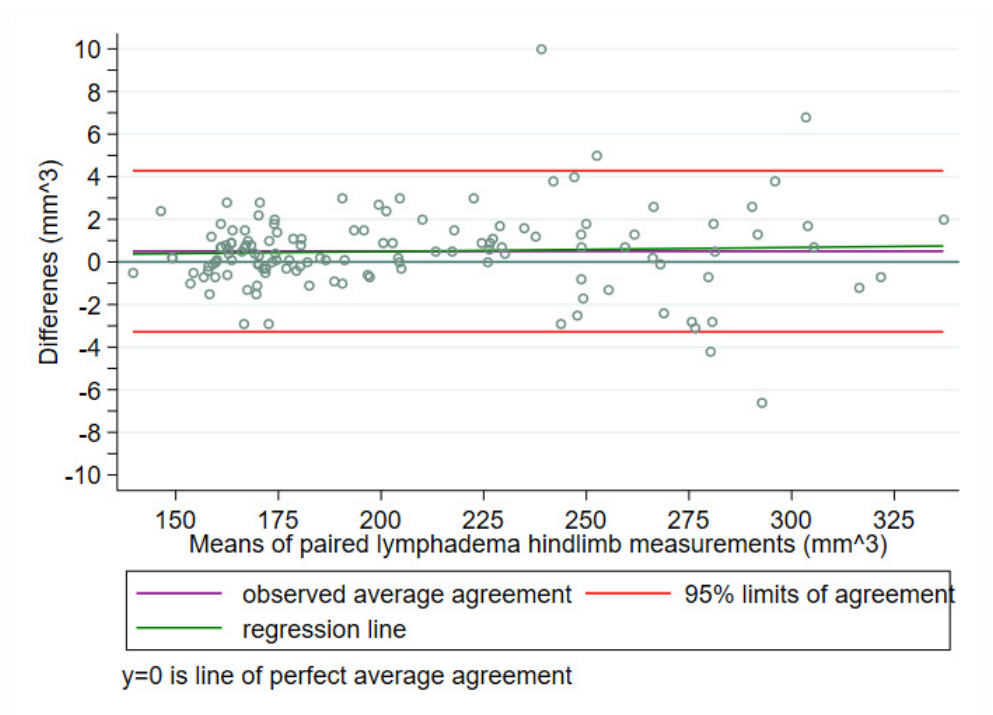
Figure 1. Classical Bland–Altman plot including the estimated LoA and a regression line of the differences on the means.